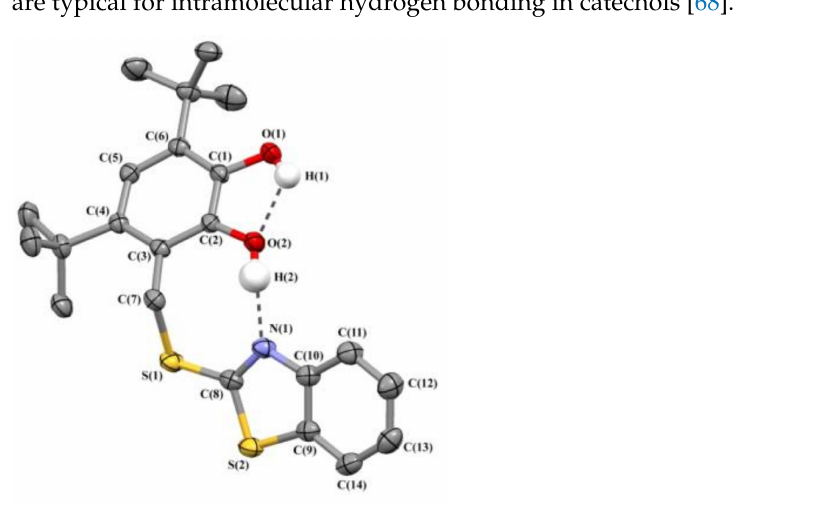
Figure 1. The X-ray structure of 8 . The ellipsoids of 50% probability. The hydrogen atoms except for hydroxy groups are omitted. The selected bonds lengths (Å): O(1)–C(1) 1.377(2), O(2)–C(2) 1.362(2),